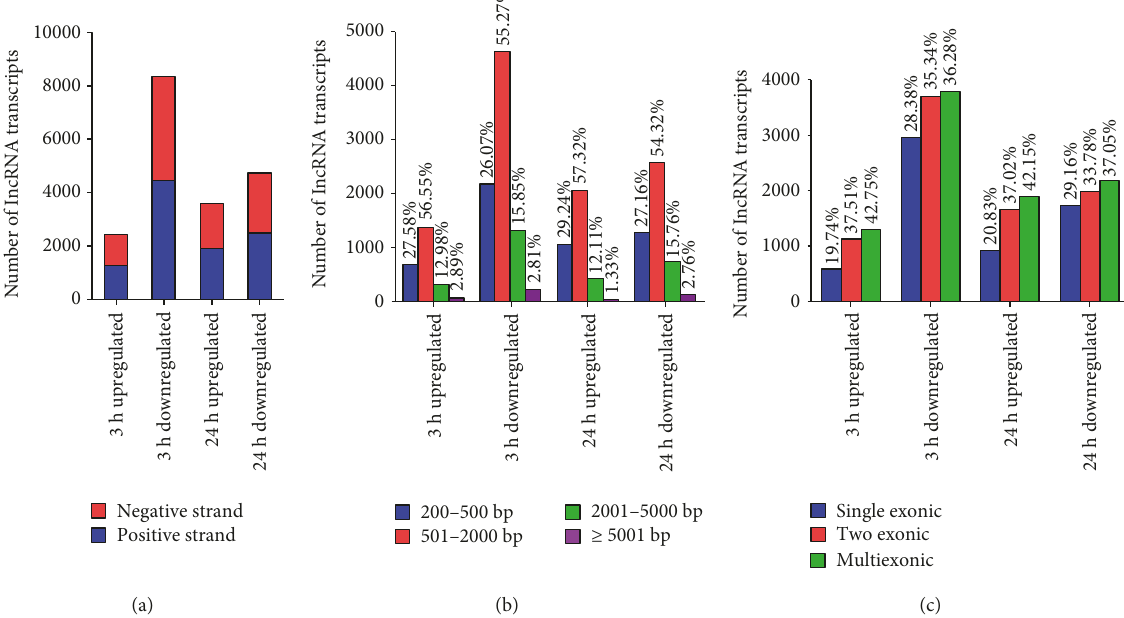
Figure 4: Cataloging of di ff erentially expressed lncRNA transcripts from LPS-treated HMECs based on (a) strand-speci fi c origin, (b) lengthwise distribution, and (c) number of